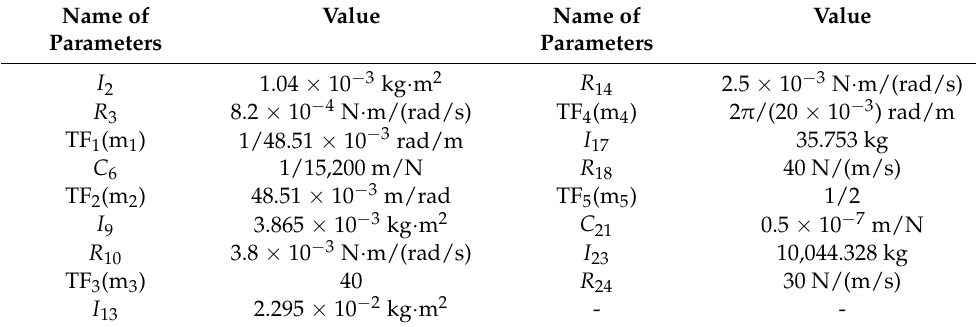
Table 4. Parameters of the towing system.